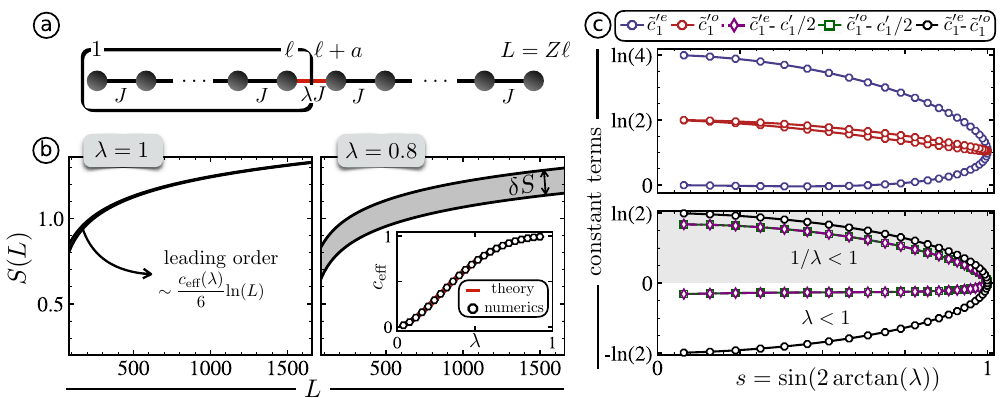
Figure 1: Entanglement entropy in a tight binding system with a single impurity link and open boundaries. a (cid:13) Illustration of the model. The bond placed between sites at (cid:96) and (cid:96) + a (corresponding to site indices j + 1, respectively) is modified, and and j 0 0 has amplitude λ J . The total system size is set to be L = Z (cid:96) . b (cid:13) Entanglement entropy of subsystem A (boxed region in a (cid:13) ) with B (non-circled region in a (cid:13) ) for λ = 1 (left) and λ = 0.8 (right) as a function of the total system size L = Z (cid:96) , with Z fixed ( 1 ) are observed, illustrated by to Z = 10. For λ < 1, non-decaying parity effects of O ( λ ) compared to the shaded region. The inset shows the predicted central charges c eff the numerically extracted leading order behavior for varying impurity strength. c (cid:13) ( s ) (upper panel, blue circles) and odd component ˜ c (cid:48) o ( s ) (upper Even component ˜ c (cid:48) e 1 1 ( s ) − ˜ c (cid:48) o ( s ) panel, red circles) of the entanglement, the corresponding difference ˜ c (cid:48) e 1 1 (cid:48) e / o ( s ) − c (cid:48) ( s ) / 2 (lower (lower panel, black circles) and the isolated boundary parts ˜ c 1 1 ( s ) , ˜ c (cid:48) o ( s ) and c (cid:48) ( s ) / 2 are obtained by panel, purple diamonds and green squares). ˜ c (cid:48) e 1 1 1 numerically fitting the data to Eq. (21) for open and Eq. (20) for periodic